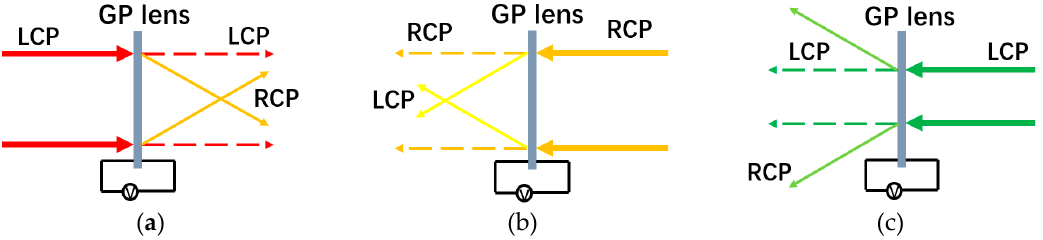
Figure 4. Virtual information light passing through the GP lens twice ( a ) the first time; ( b ) the second time; ( c ) Ambient light passing through the GP lens. The solid arrows represent first-order diffracted light, and the dashed arrows are zero-order light.